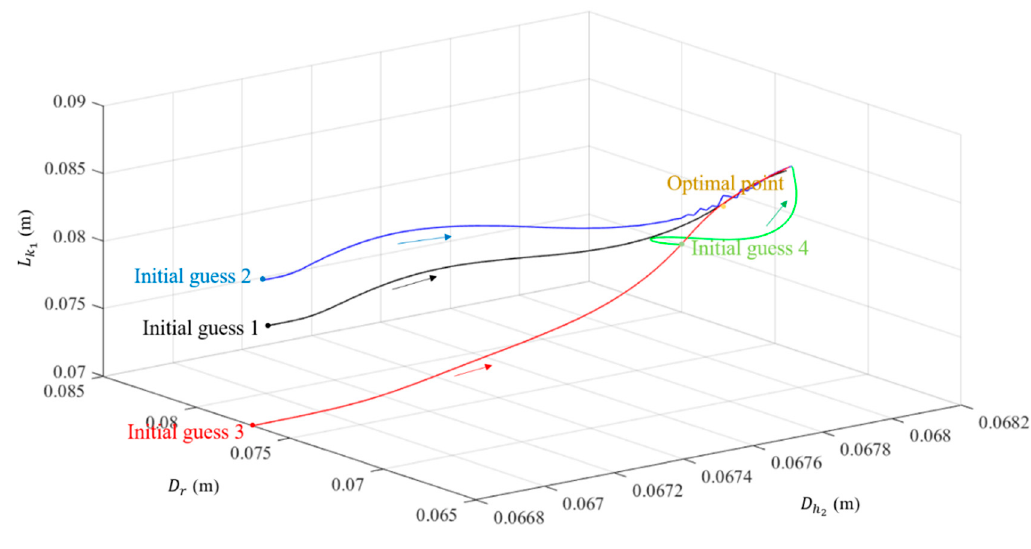
Figure 11. Convergence trajectory of different sets of initial guesses. Table 8. Numerical values of initial guesses and the optimal point.